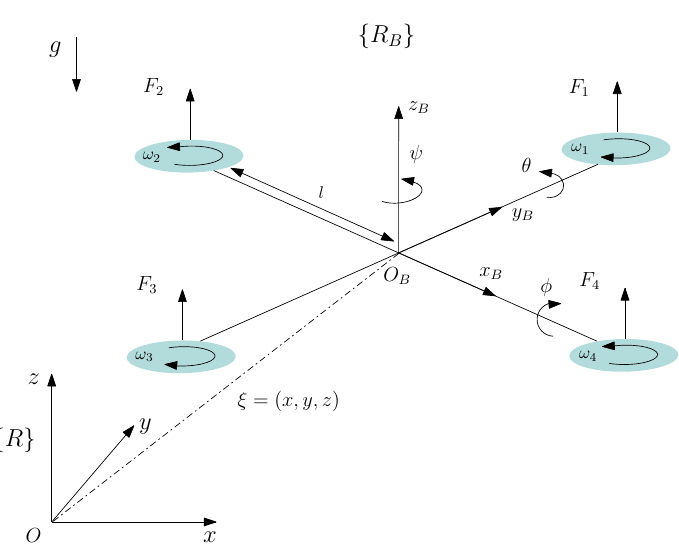
Figure 3. Quadrotor configuration with body-fixed frame and inertial